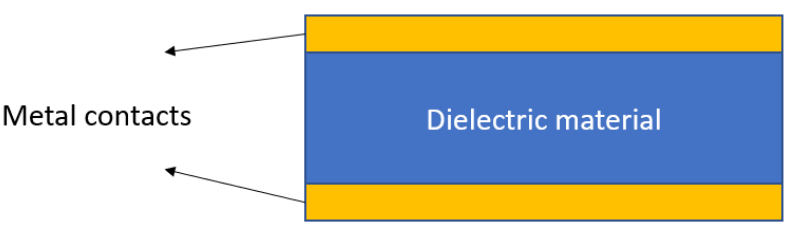
Figure 2. Illustration of a capacitor used for the measurement of permittivity. Permittivity can be determined from the measurement of capacitance, area, and thickness under an electric field, according to Equation (5).